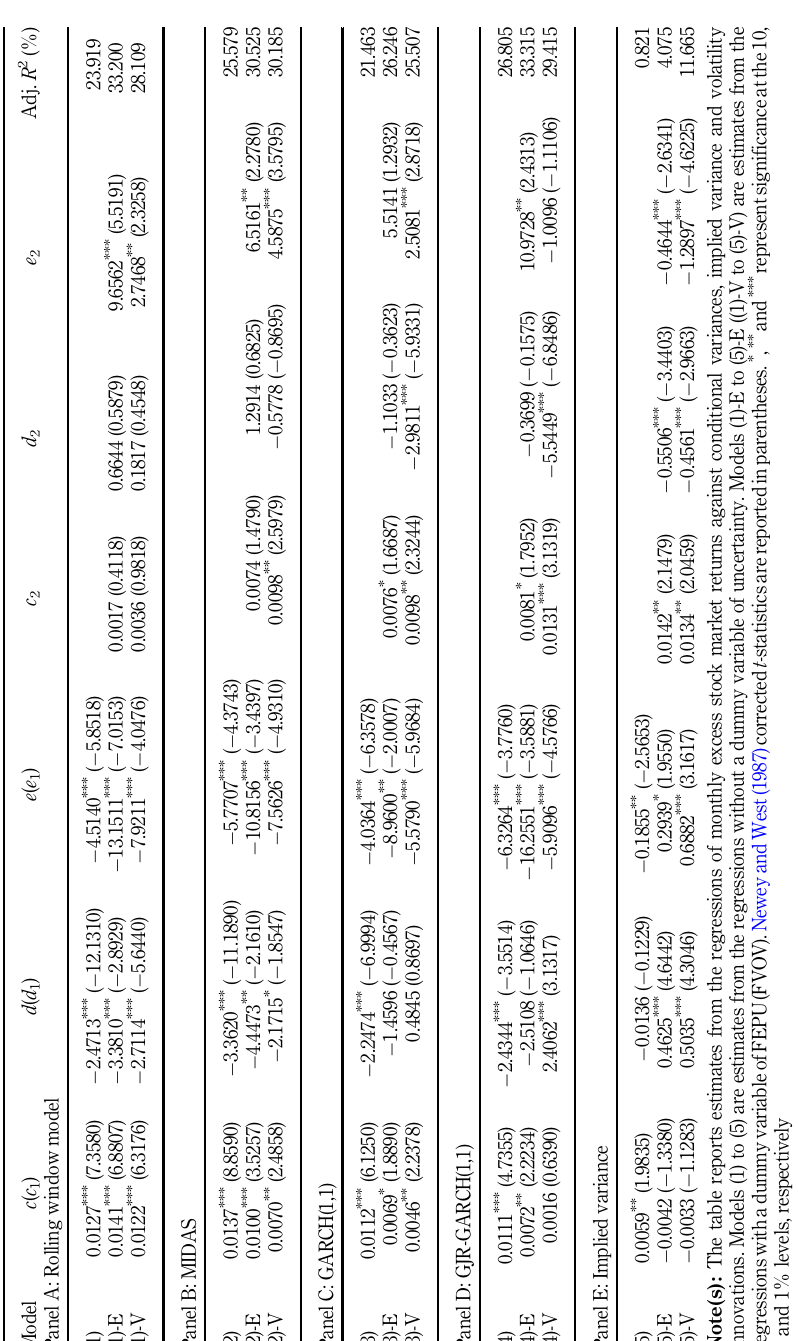
market returns against conditional variances, implied variance and volatility innovations with